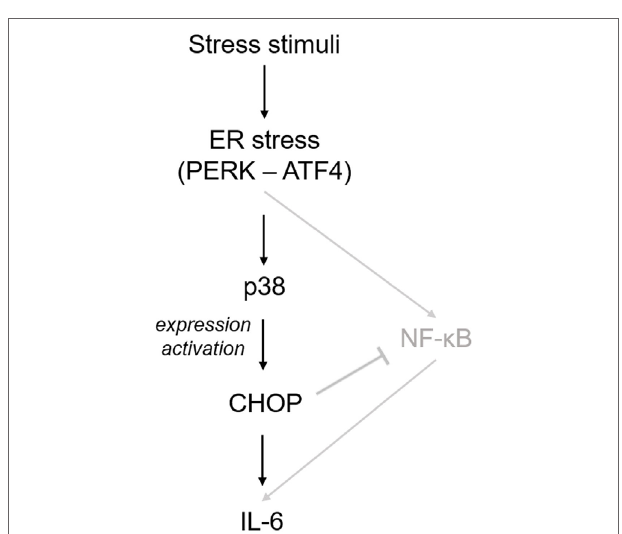
FigUre 7 | Suggested mechanism of endoplasmic reticulum (ER) stress- induced inflammatory responses in intervertebral disc (IVD) cells. Stress stimuli (such as biomechanical alterations or low pH) can cause dysregulation of calcium homeostasis and sub-lethal ER stress. This in turn activates p38, which induces the expression and phosphorylation of C/EBP homologous protein (CHOP) and subsequent IL-6 release. In its initial phase, ER stress response may help IVD cells to cope with non-physiological stimuli, while severe ER stress may promote inflammation and apoptosis. A previous IVD-related study (20) showed that ER stress activates IL-6 release through NF- κ B, which is negatively regulated by CHOP (shown in